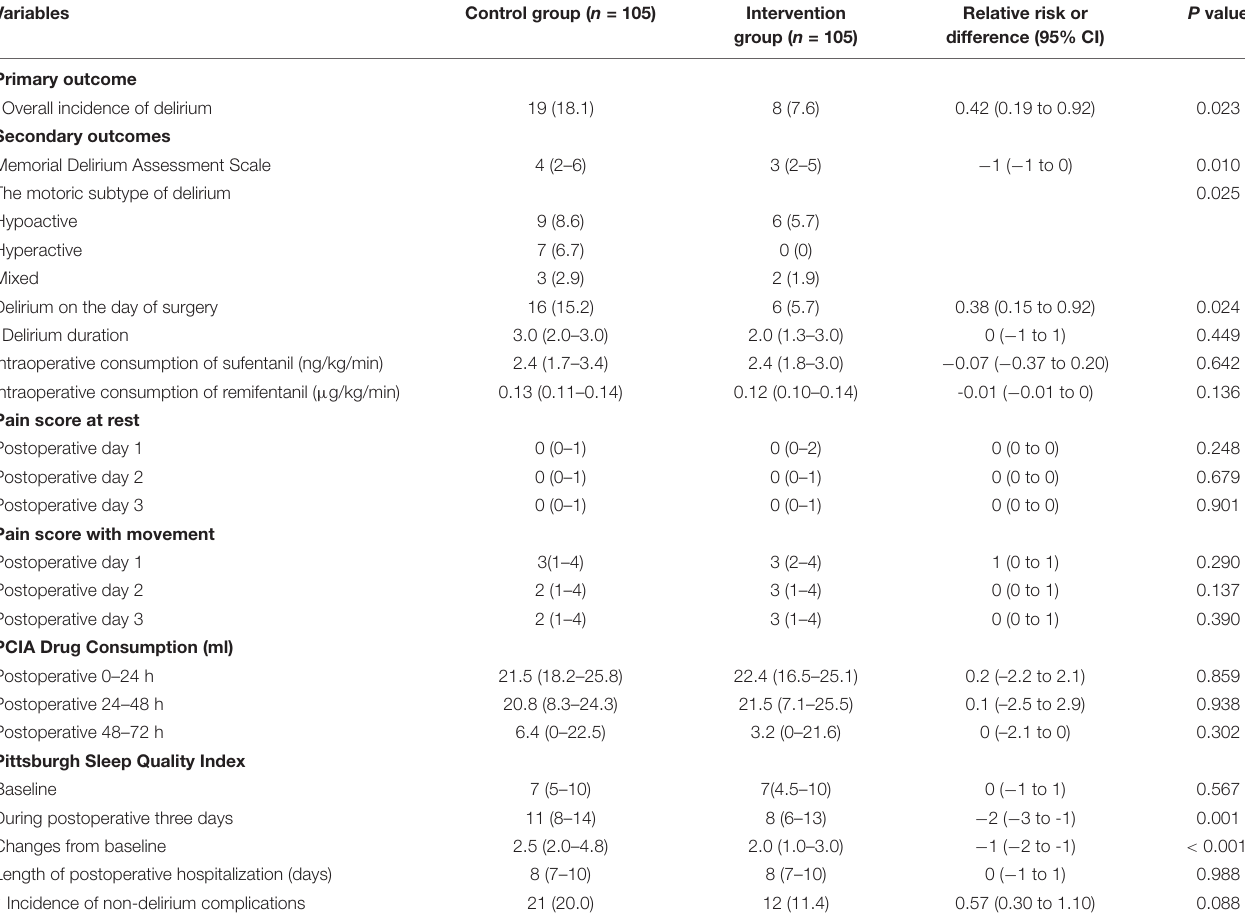
TABLE 2 | Effectiveness outcomes analyzed in the intention-to-treat population. Variables Control group ( n = 105) Intervention